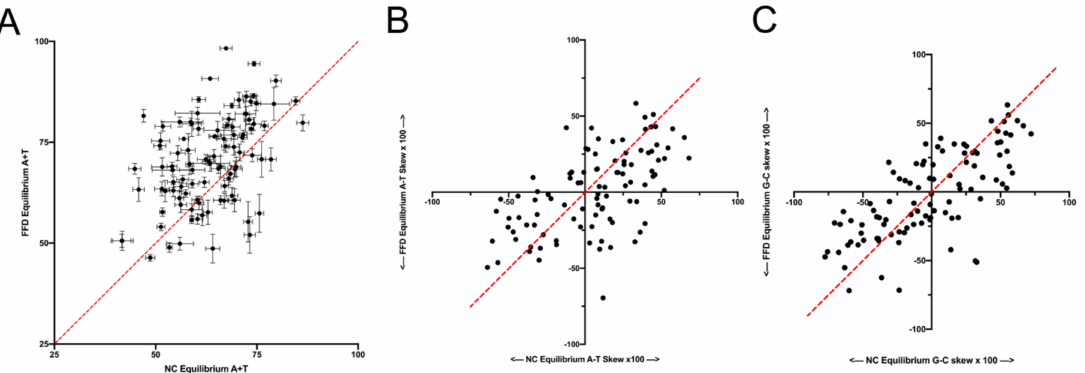
Figure 3. Comparison of FFD and NC sites in the equilibrium composition predicted by the substitu- tion dynamics in each context. ( A ) Predicted A+T content, ( B ) predicted A-T skew ((A − T)/(A+T)) at equilibrium and ( C ) predicted G-C skew ((G − C)/(G+C)). For the predicted A+T content, error bars were determined using the resampling methodology described in the Materials and Methods